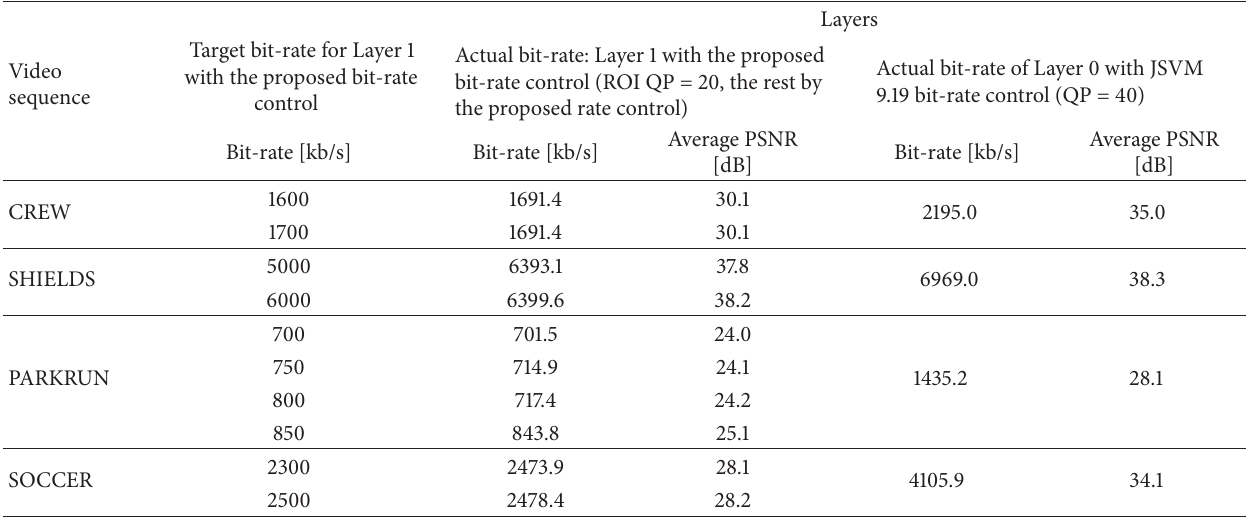
Table 9: Bit-rate control experimental results for “CREW,” “SHIELDS,” “PARKRUN,” and “SOCCER” video sequences (ROI QP in Layer 1